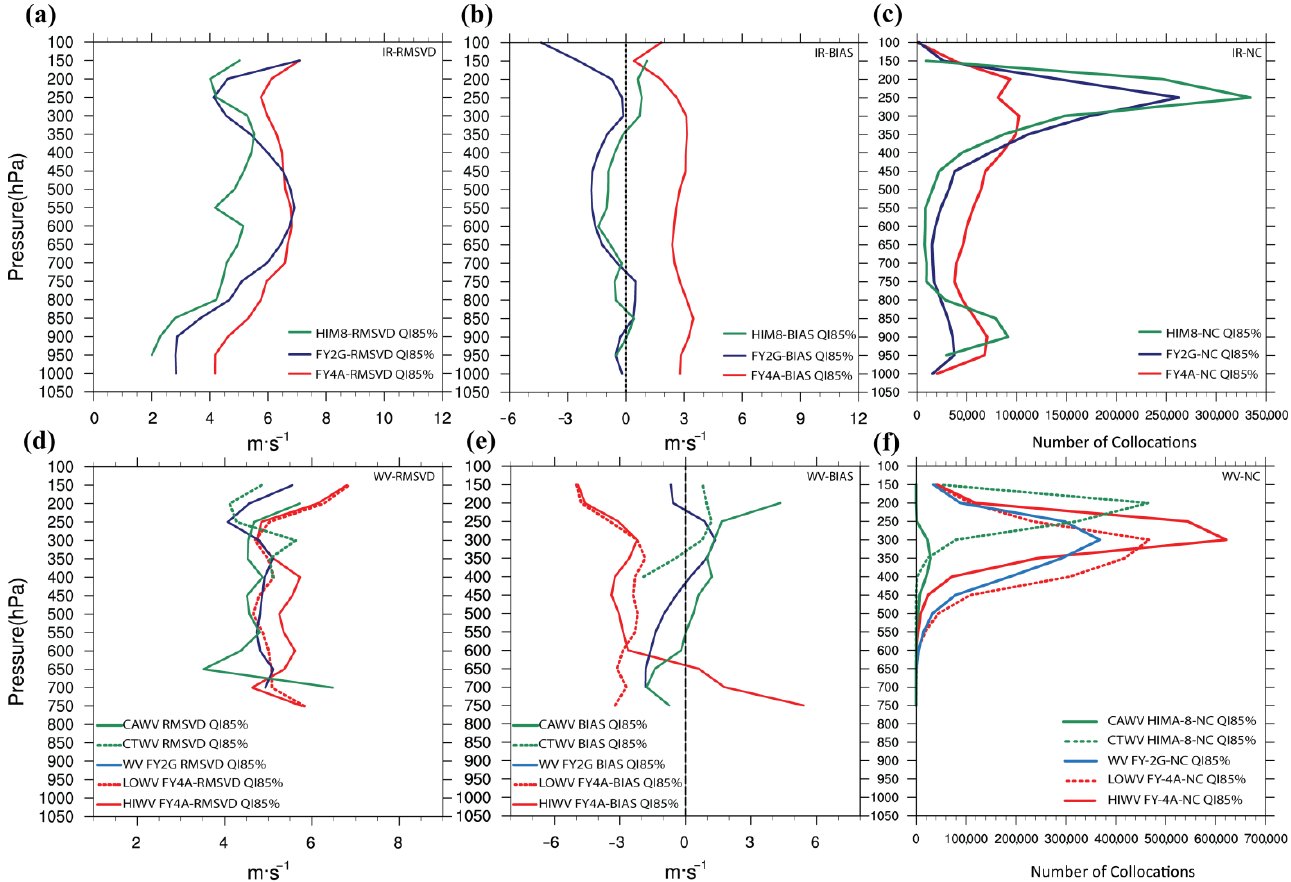
Figure 8. Comparisons of the vertical profile in December 2018 of the three sets of AMVs at QI 85% from FY-2G, FY-4A, and HIMA-8 IR AMVs for ( a ) the RMSVD, ( b ) the BIAS, ( c ) the numbers of collocations while WV AMVs for ( d ) the RMSVD, ( e ) the BIAS and ( f ) the numbers of collocations.